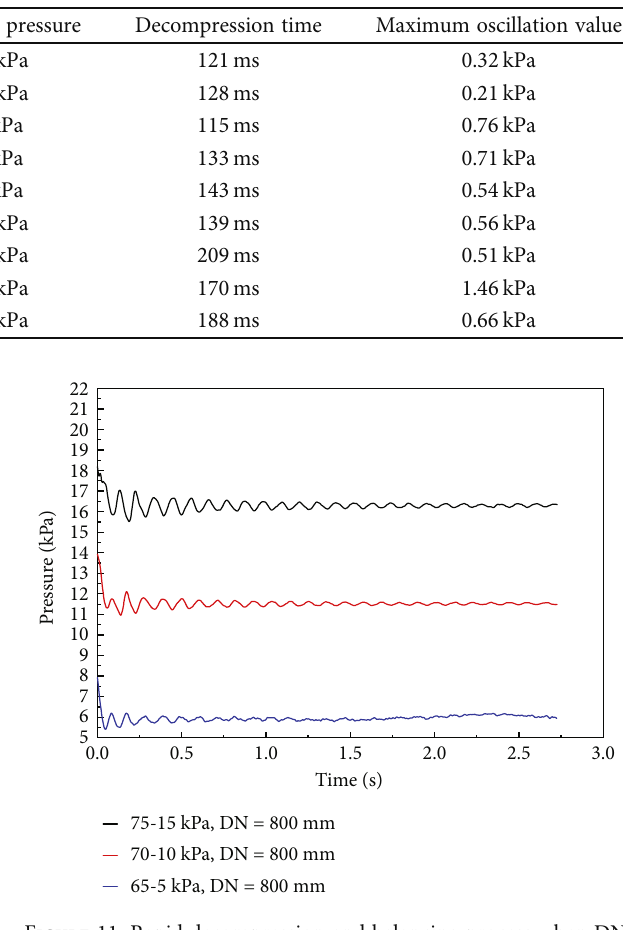
Figure 10: Rapid decompression test when DN = 800 mm .